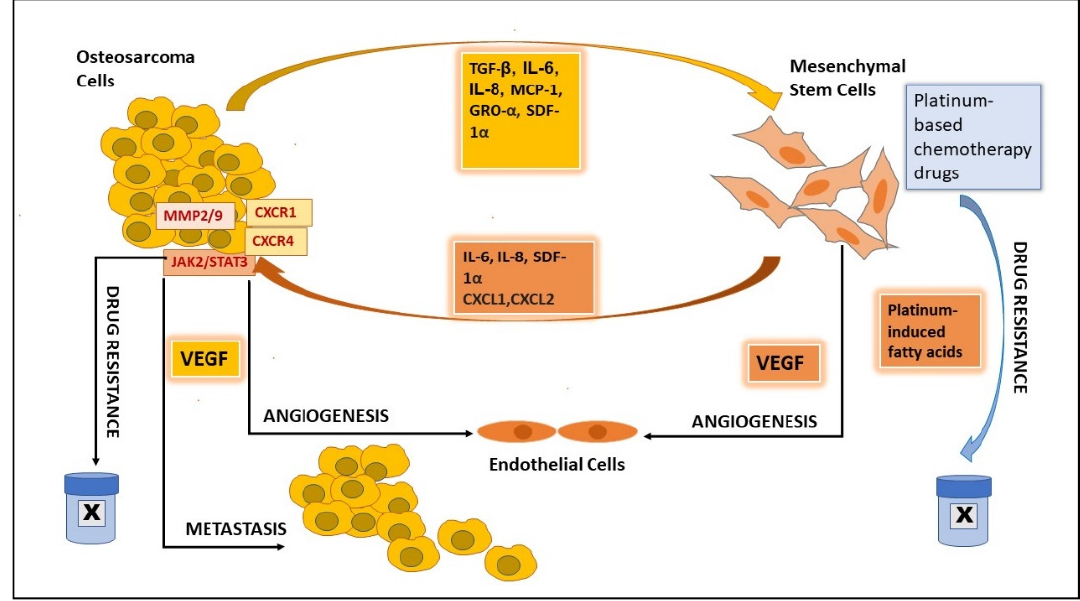
Figure 2. Graphical presentation of the role of mesenchymal stem cells in angiogenesis, metastasis, and drug resistance in osteosarcoma.